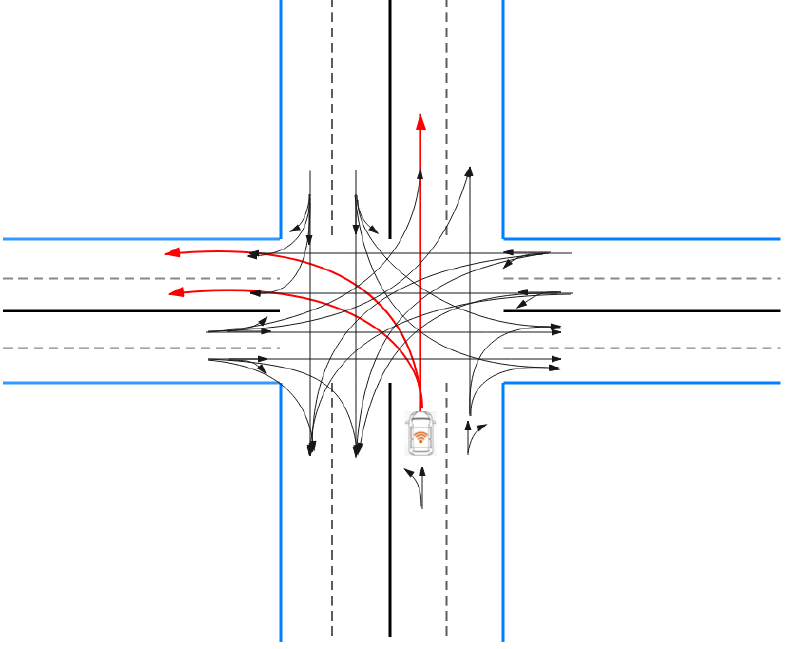
Figure 7. The scene of trajectory